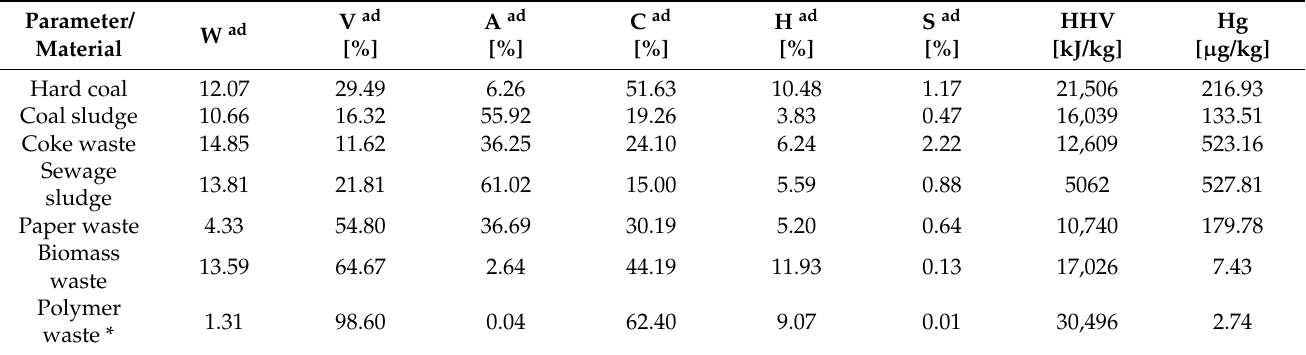
Table 2. Proximate and ultimate analyses of waste; content of mercury in